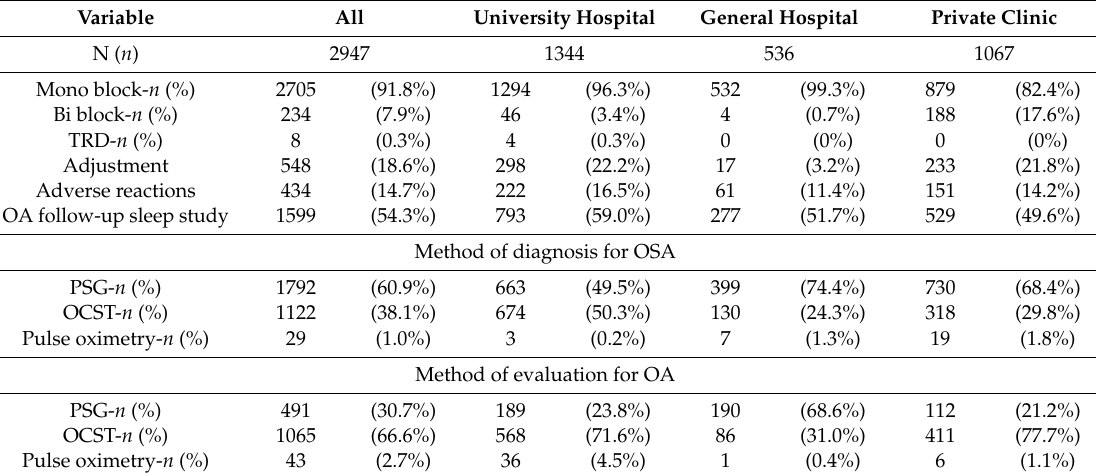
Table 2. Oral appliance type and evaluation